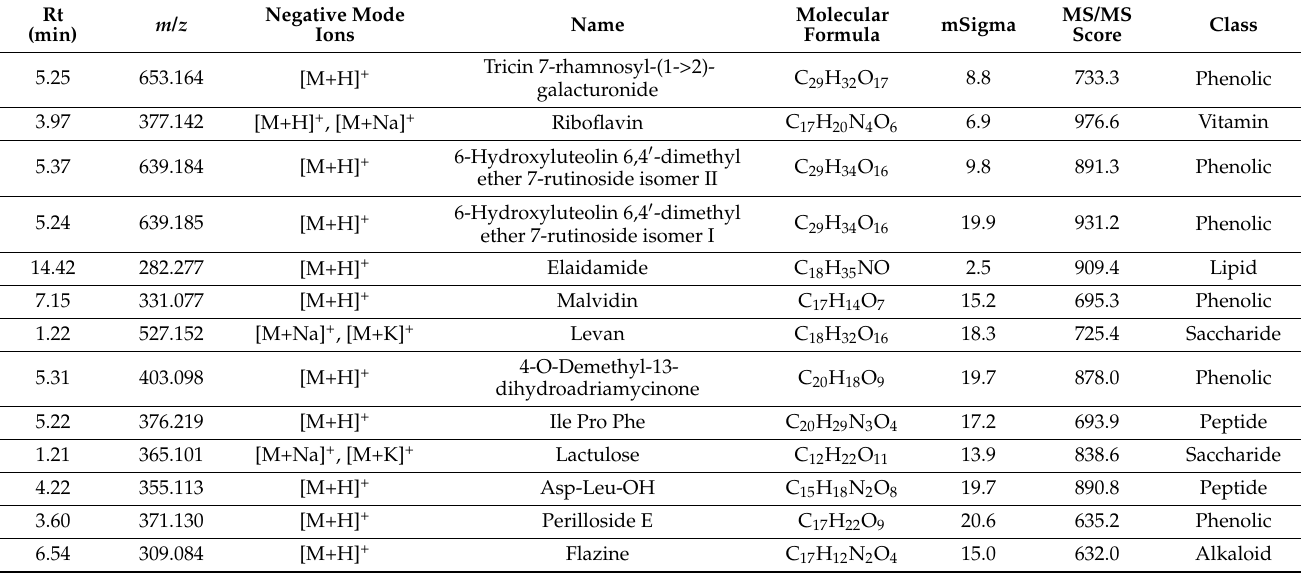
Table 7. Phenolic-rich extract characterization in positive ionization mode (From MetaboScape ® , ordered by decrease order of signal